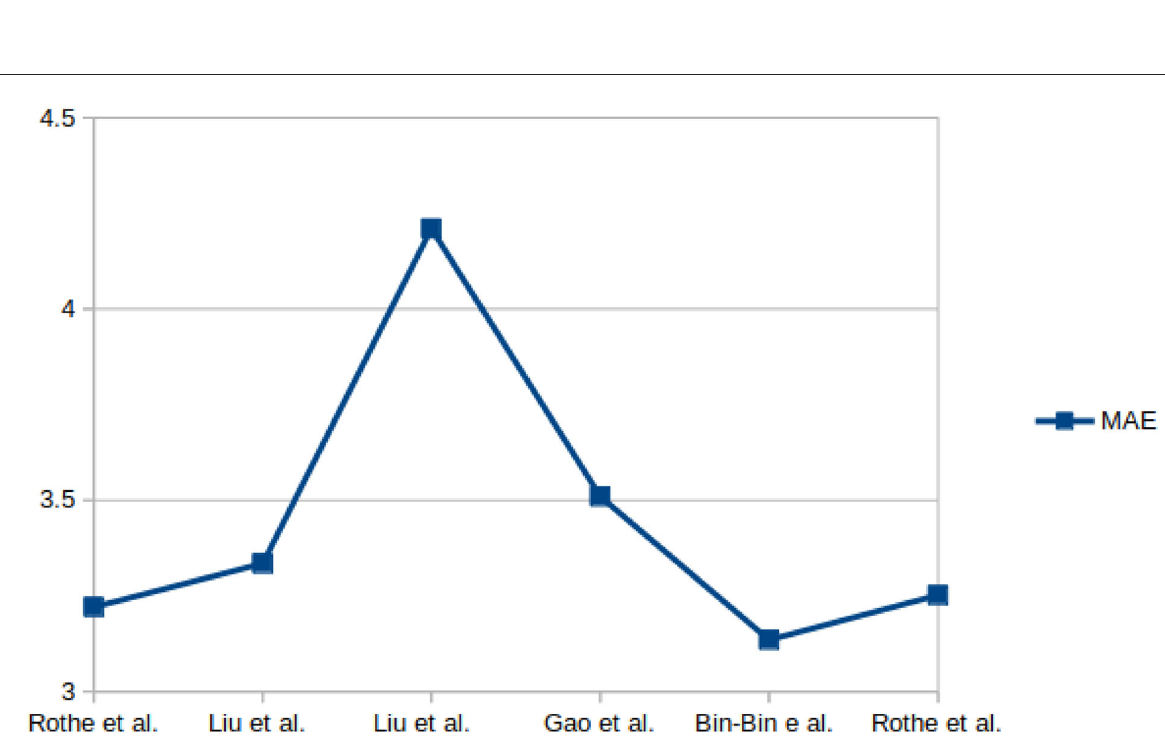
FIGURE6 Performance, in terms of MAE, achieved by some authors on the Chalearn LAP-2015